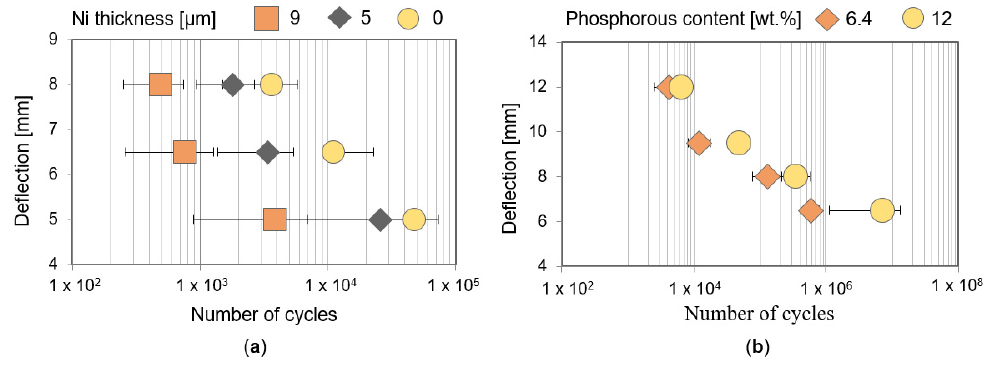
Figure 8. Number of cycles dependent on the deflection and ( a ) the thickness of the nickel layer, whereas the roughness R a was 1.9 µm; ( b ) the phosphorous content in the nickel layer, whereas the roughness R a was 6.5 µm and nickel thickness was 3 µm.